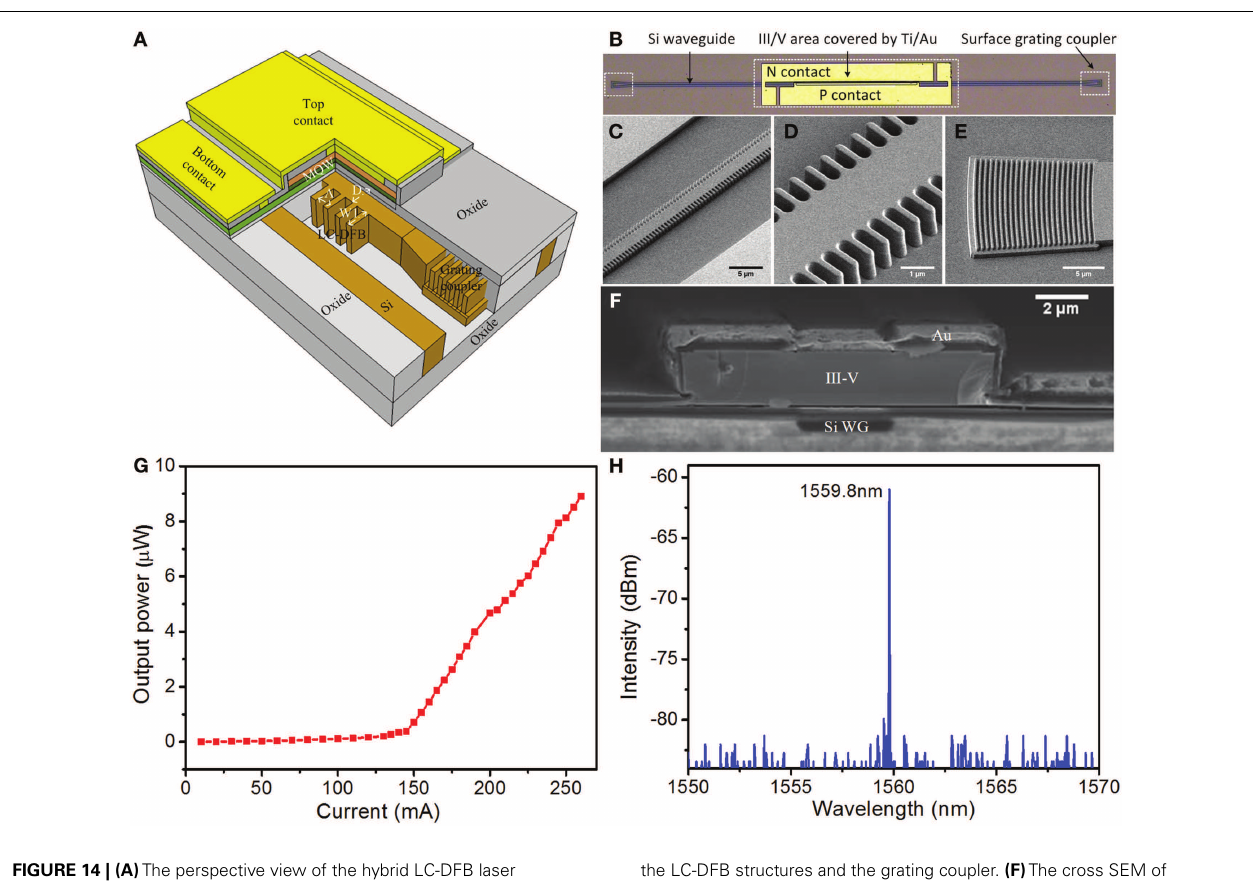
FIGURE 14 | (A) The perspective view of the hybrid LC-DFB laser integrating with surface grating coupler, with illustration of the key design parameters. Λ : grating period, D : the ridge width, and W 1 : the grating teeth width. (B) Top-view optical microscope image of a LC-DFB hybrid laser integrated with vertical surface coupler. (C–E) The SEM of